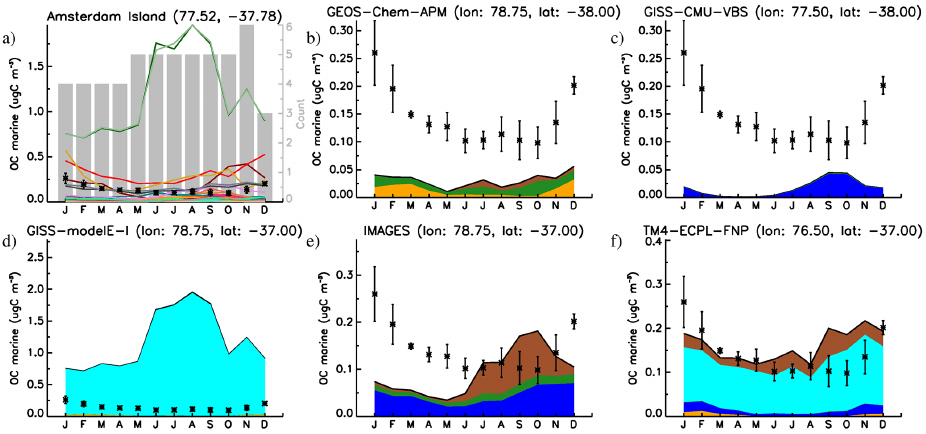
Figure 23. Same as in Fig. 18, for Amsterdam Island, Indian Ocean (marine, years 2003–2007). For the chemical composition in (b–f) , brown is tPOC, green is trSOC, cyan is mPOC, blue is ntrSOC, and orange is